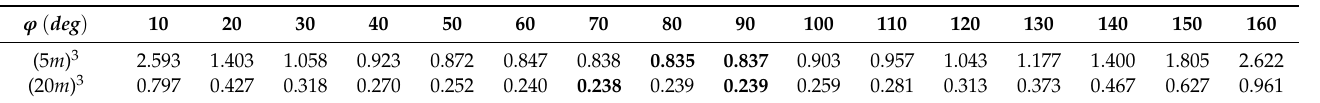
Table 5. The 3D RMSPE ∆ p (m) with varying ϕ in the 5 m × 5 m × 5 m and 20 m × 20 m × 20 m environments for the LOS condition.